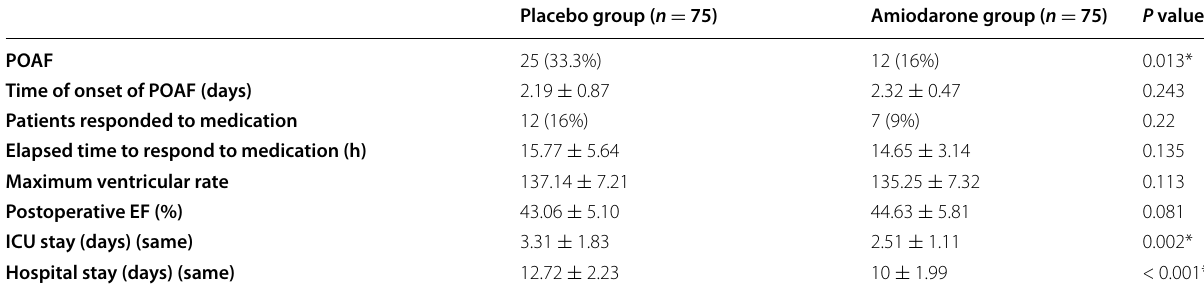
Data presented as mean SD or frequency (%) ± AF atrial fibrillation, POAF postoperative atrial fibrillation, ICU intensive care unit, EF ejection fraction, RR Relative risk *Significant P value <